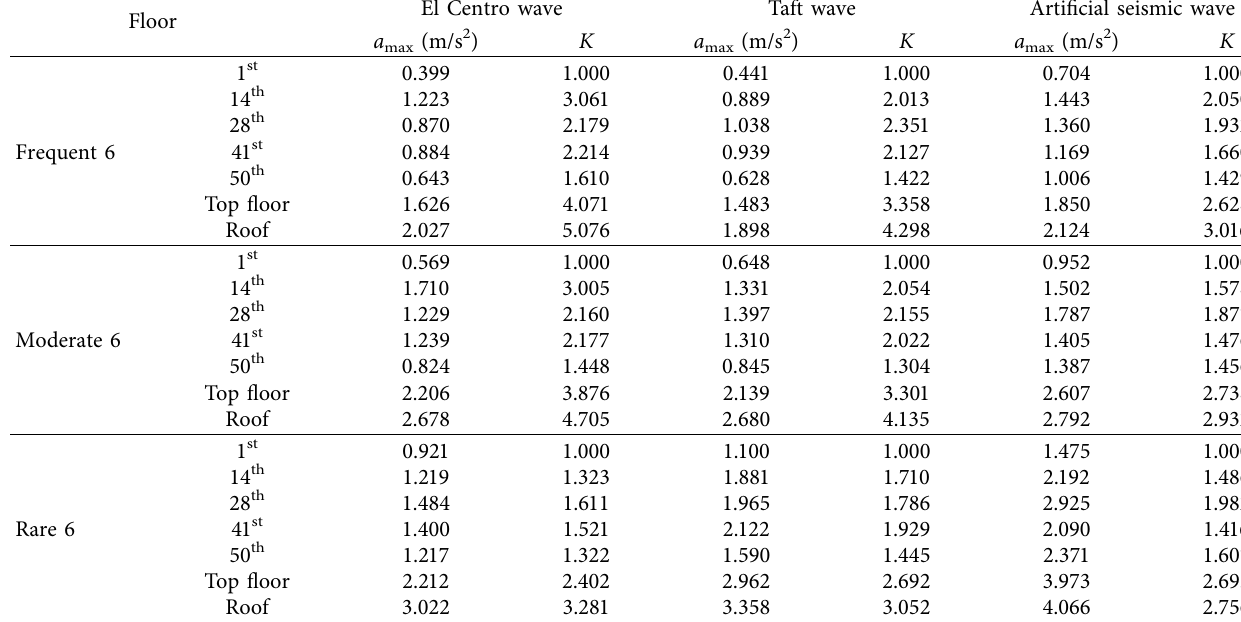
Figure 6: Envelope of acceleration amplification factor under different earthquake levels: (a) El Centro seismic excitation; (b) Taft seismic excitation; (c) artificial seismic wave (USER1). Table 8: Peak acceleration and acceleration amplification